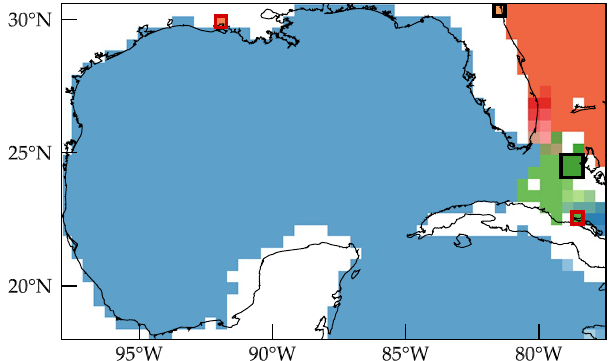
Figure 2. Grouping of the Markov-chain states into classes according to their communication type. Bins indicated with the same color belong to the same class. The are 31 communicating classes covering the eGoM domain. Two of these classes are closed (red boxes) and 2 are both closed and absorbing (black boxes); they do not offer any insight into the Lagrangian dynamics other than mere beaching of drifters. Computations carried using Matlab R2017a (http://www.mathworks.com/) and visualization using Tecplot 360 2016 R2 (http://www.